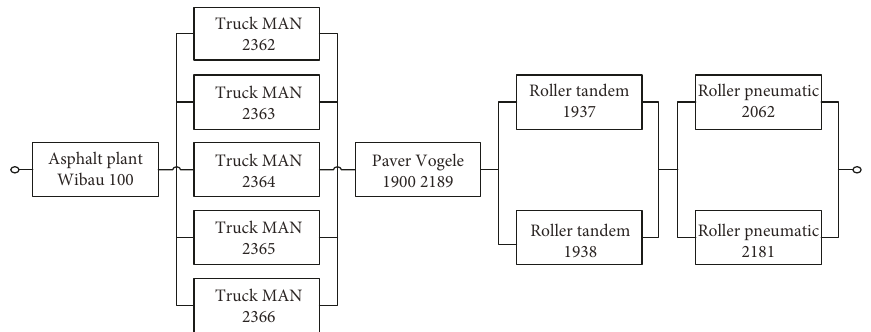
Figure 3: System for production and embedding of bitumen-bounded materials. Table 1: Availability and capacity of